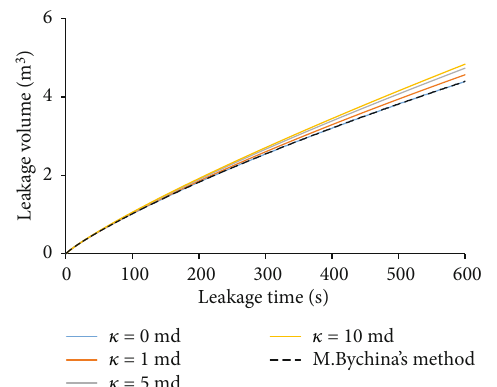
Figure 9: Leakage volume graph under di ff erent formation permeability.